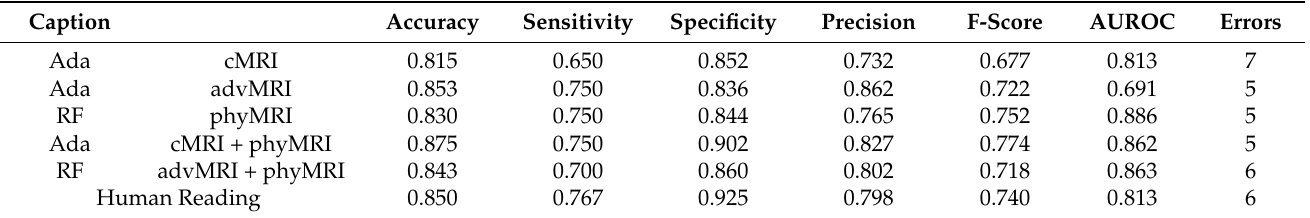
Table 4. Performance parameters for the top ML classifiers of the five MRI data sets and human reading of the test